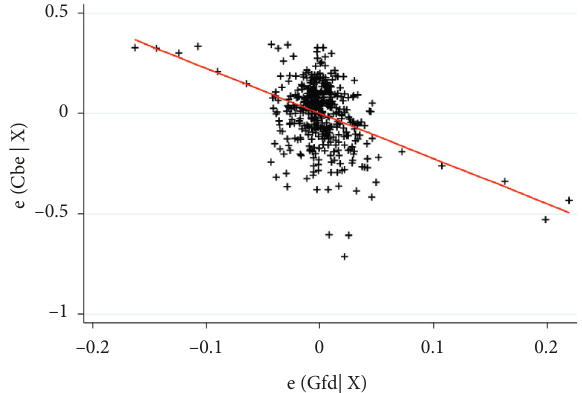
Figure 2: Partial correlation (before adding control